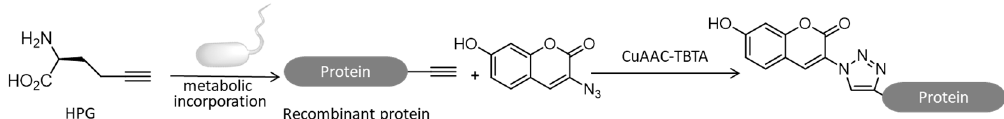
Figure 6. TBTA assisted CuAAC labeling of newly synthesized proteins in bacterial cells. Met analogs containing terminal alkyne were metabolized and incorporated into target proteins in bacterial cells, and then TBTA assisted CuAAC to react with azide modified coumarin fluorophores.